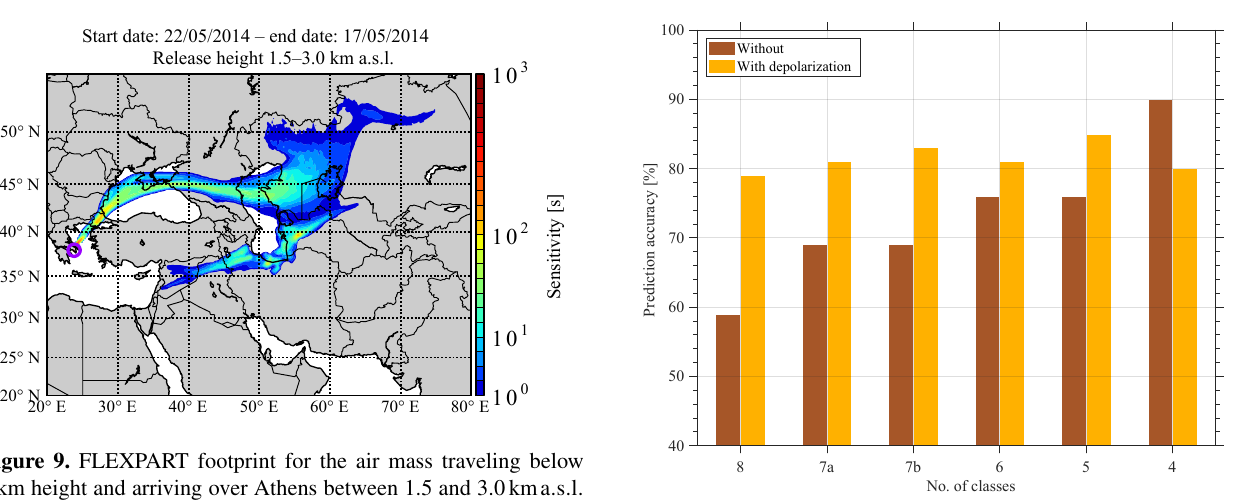
Figure 10. Prediction accuracy for the different aerosol classes with and without depolarization